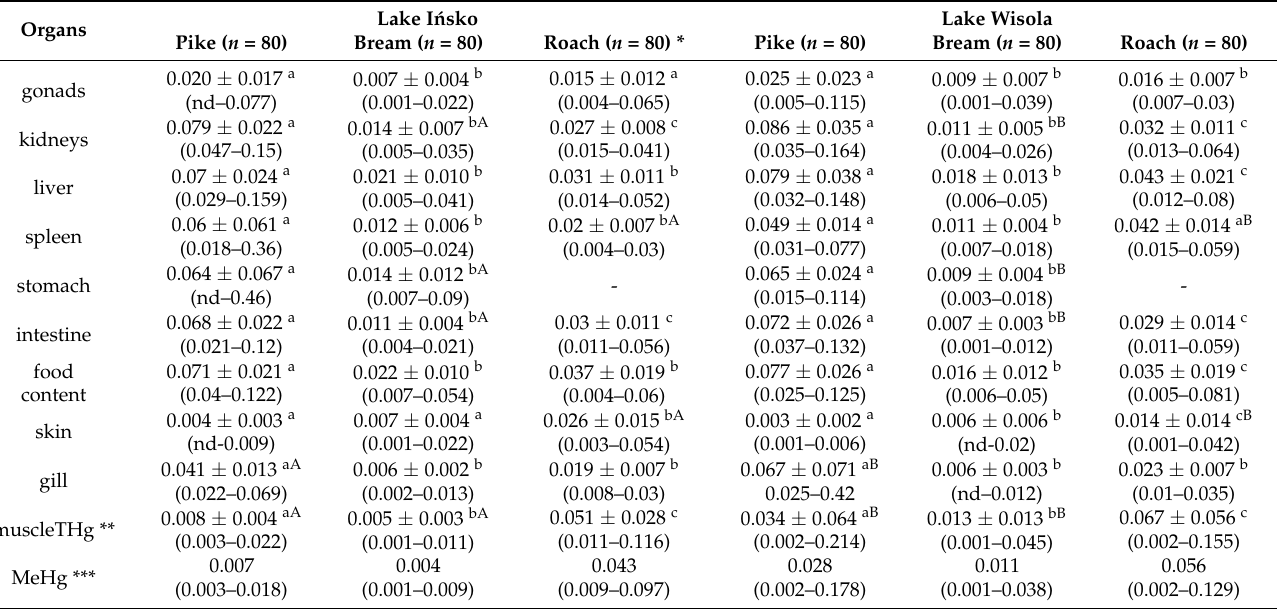
Table 5. Mercury concentration in organs and food content of fish from I´nsko and Wisola lakes (mg/kg ww; mean ± SD;